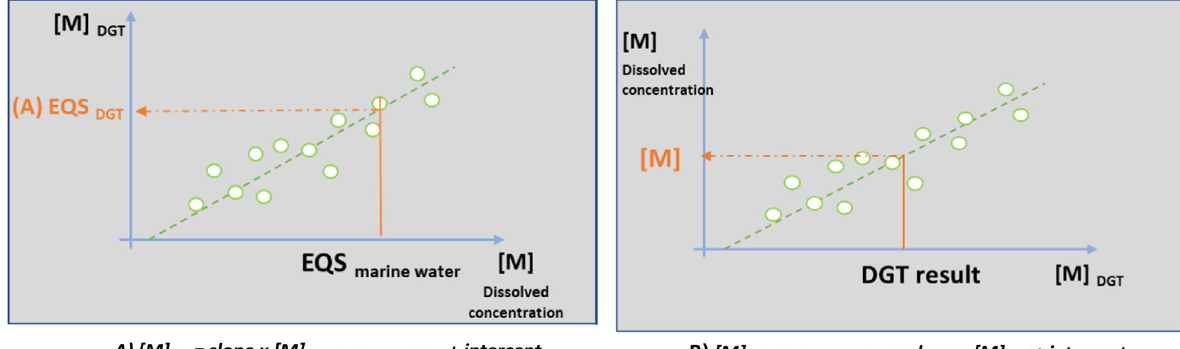
Fig. 1 Example of the generic relationships: A Metal concentration ([M] DGT ), representing the labile concentration for DGTs and dissolved concentration for spot samples, [M] Dissolved Concentration , and determination of (A)‑EQS DGT ; B [M] Dissolved Concentration and [M] DGT and prediction of dissolved metal concentrations ([M]; orange) from DGT